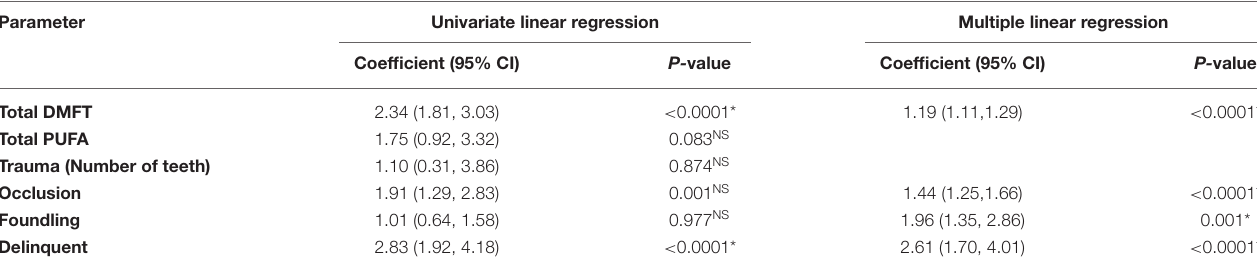
TABLE 7 | Correlation between oral findings (DMFT score, PUFA score, occlusion status, dental trauma) and total OHRQoL scores of foundling and delinquent children groups with mainstream